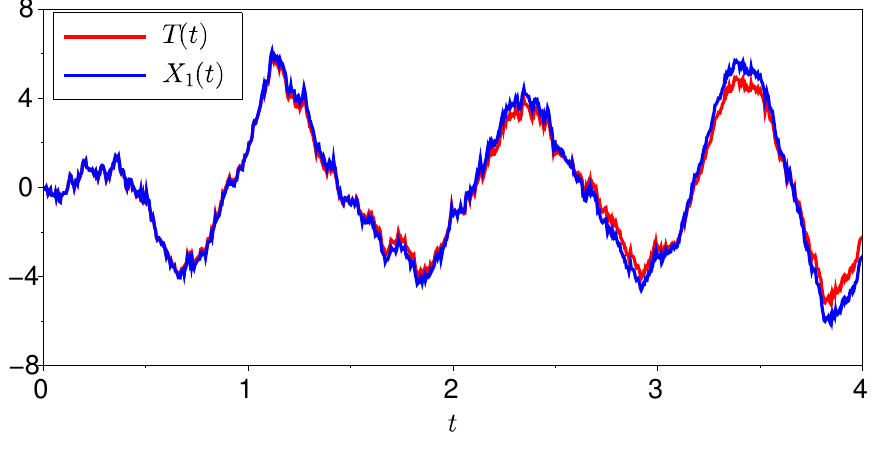
Figure 3. Comparison of T ( t ) from (5) and X 1 ( t ) from